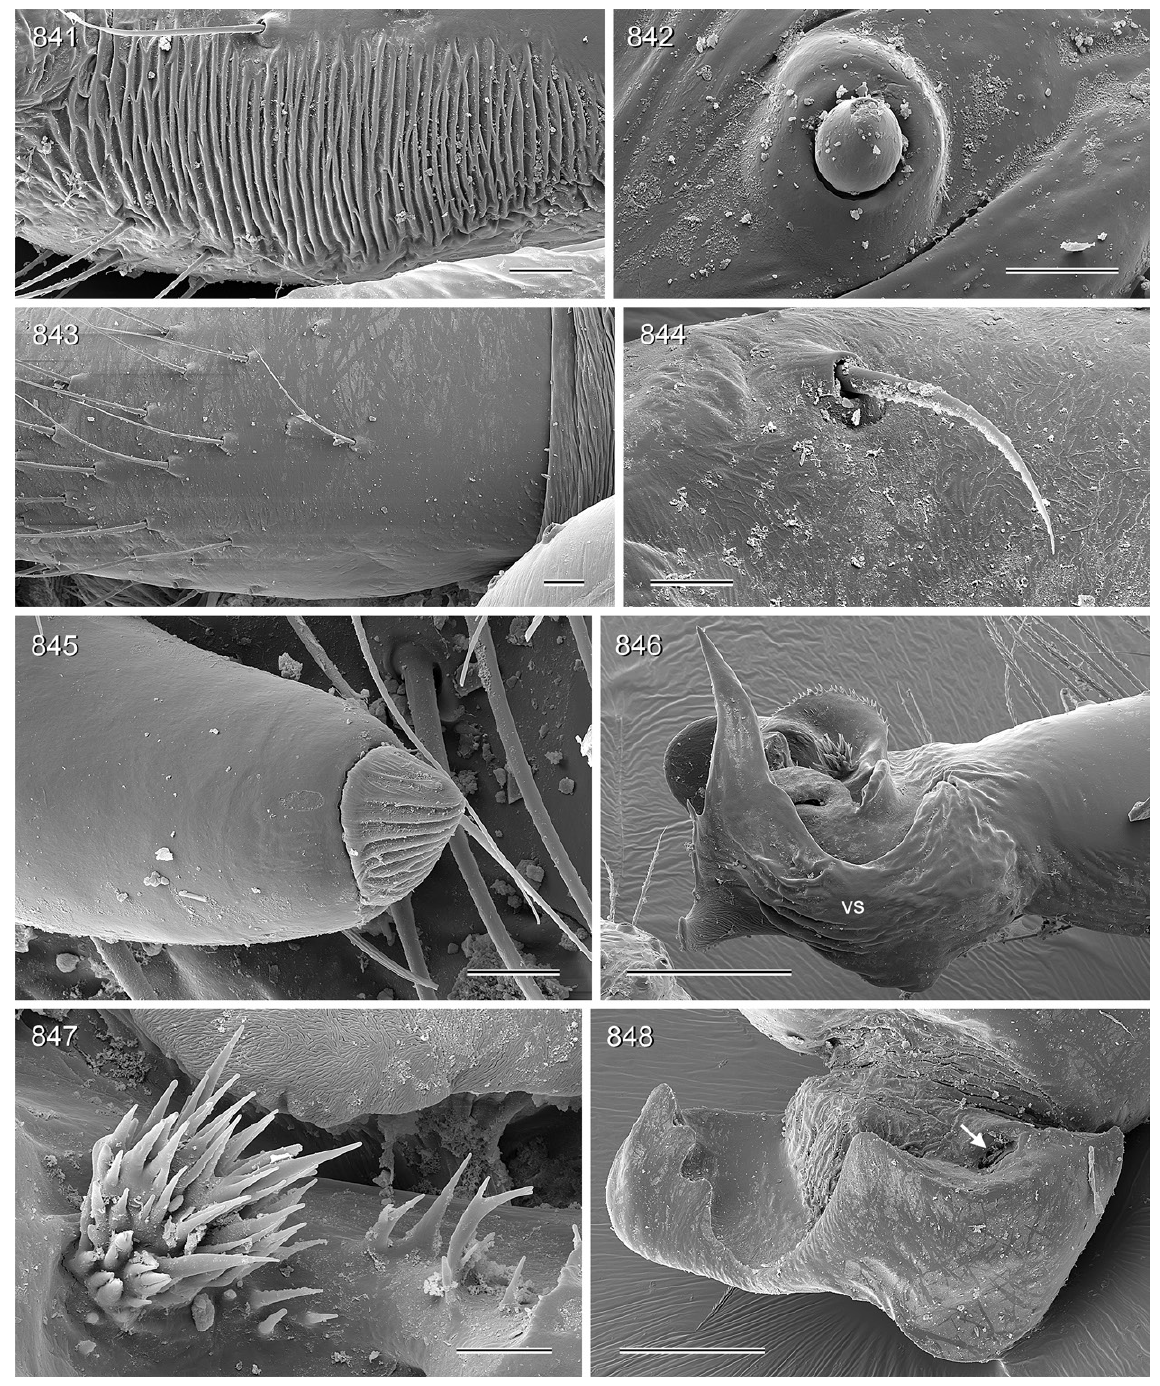
Figs 841–848. Crossopriza surobi sp. nov.; male and female from Afghanistan, SE of Surobi (MHNG). 841–842 . Male stridulatory file and corresponding pick on palpal femur. 843–844 . Female cheliceral side and proximal prolateral hair on female palpal femur. 845 . Tip of male cheliceral apophysis. 846 . Tip of left procursus, retrolateral-ventral view. 847 . Detail of procursus tip. 848 . Distal sclerite of left genital bulb, prolateral (slightly ventral and distal) view; arrow: sperm duct opening. Abbreviation: vs = ventral sclerite. Scale bars: 841, 843 = 20 µm; 842, 844–845, 847 = 10 µm; 846, 848 = 100